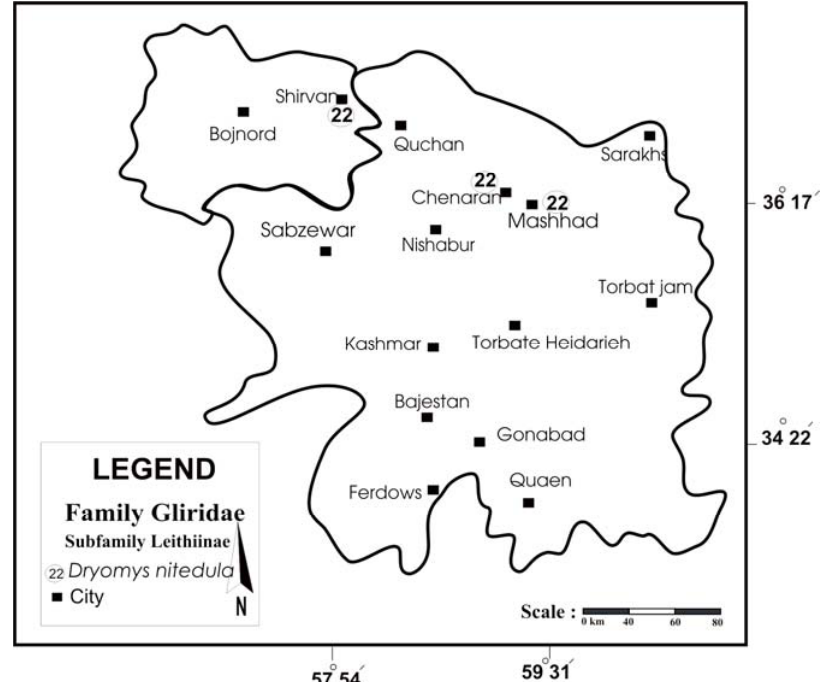
F IG . 5. - Map of northeastern Iran with collecting sites for Dryomys nitedula , indicated with number 22.